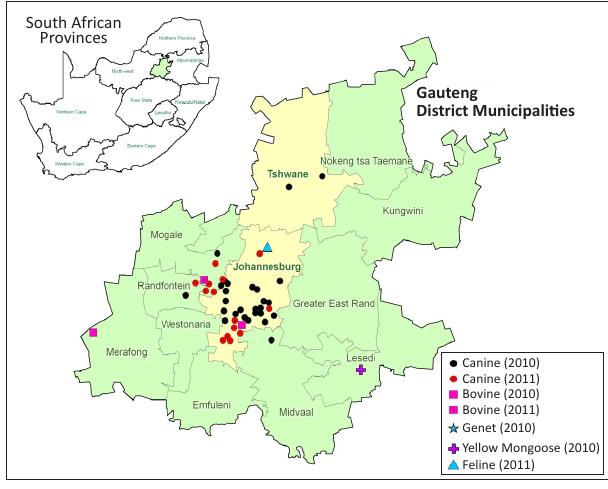
FIGURE 1: Distribution of confirmed animal rabies cases for 2010 – 2011 outbreak in Gauteng